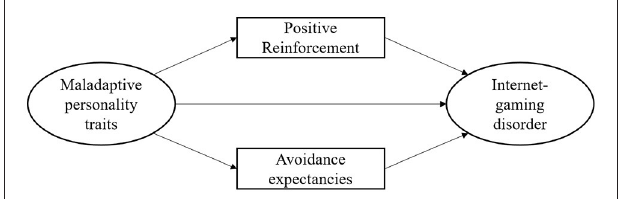
FIGURE 1 | The current structural equation model. Visualization of the main assumptions of the current structural equation model including symptoms of an Internet-gaming disorder as dependent